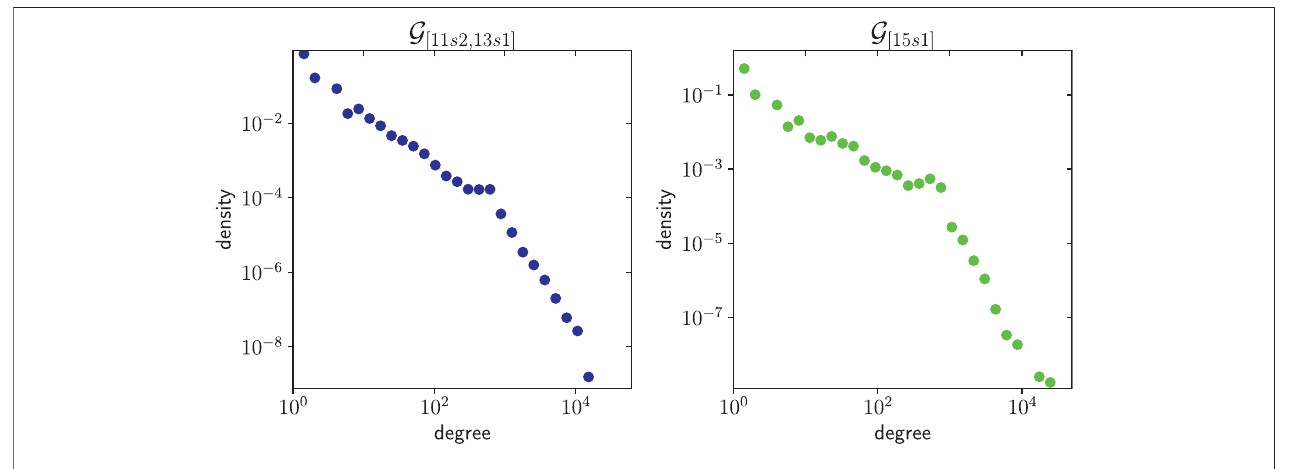
FIGURE 3 | Degree distribution for cumulative G [ 11s2 , 13s1 ] and partial G [ 15s1 ] .